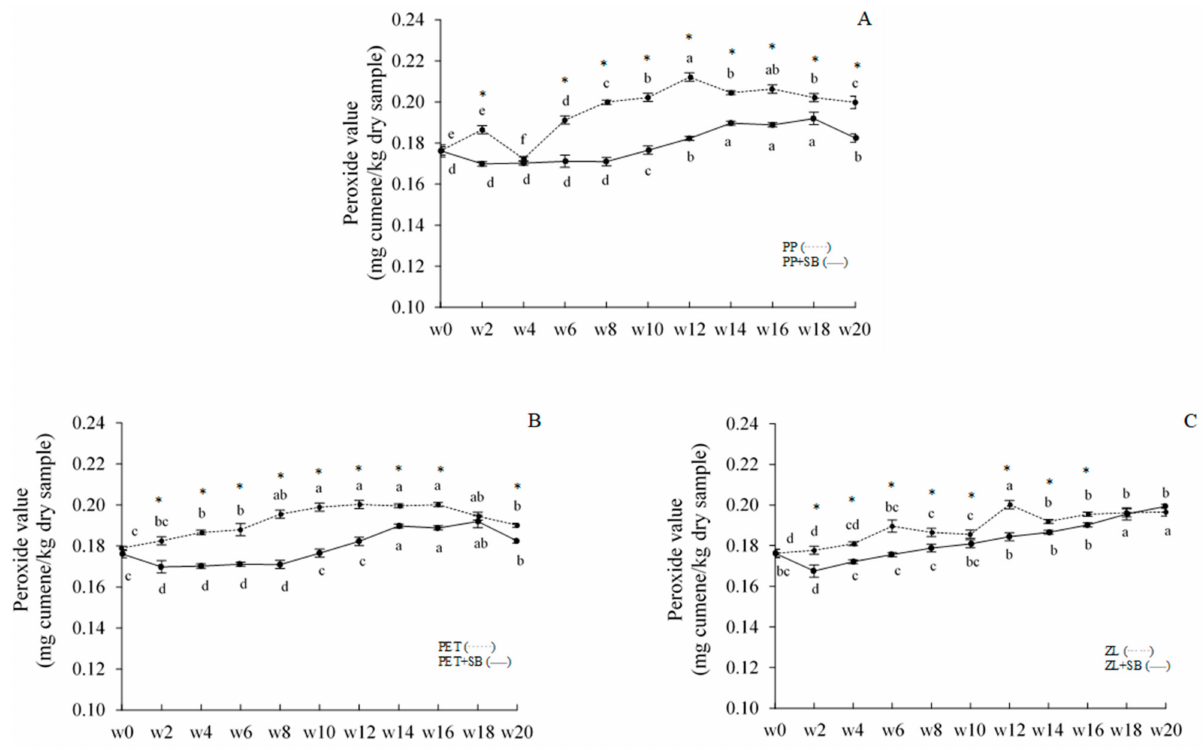
Figure 2. Change in peroxide value (PV) of dried chili fish paste during storage in various packaging at room temperature (25 ◦ C). ( A ): PP ( . . . . . . )/PP+SB: ( ____ ), ( B ): PET ( . . . . . . )/PET+SB: ( ____ ), and ( C ): ZL ( . . . . . . )/ZL+SB: ( ____ ). Significant differences between with/without added 0.1% SB in samples stored in the same packaging material are indicated by an asterisk (*) ( p < 0.05). Different lowercase letters in the same column denote significant differences ( p < 0.05) due to storage